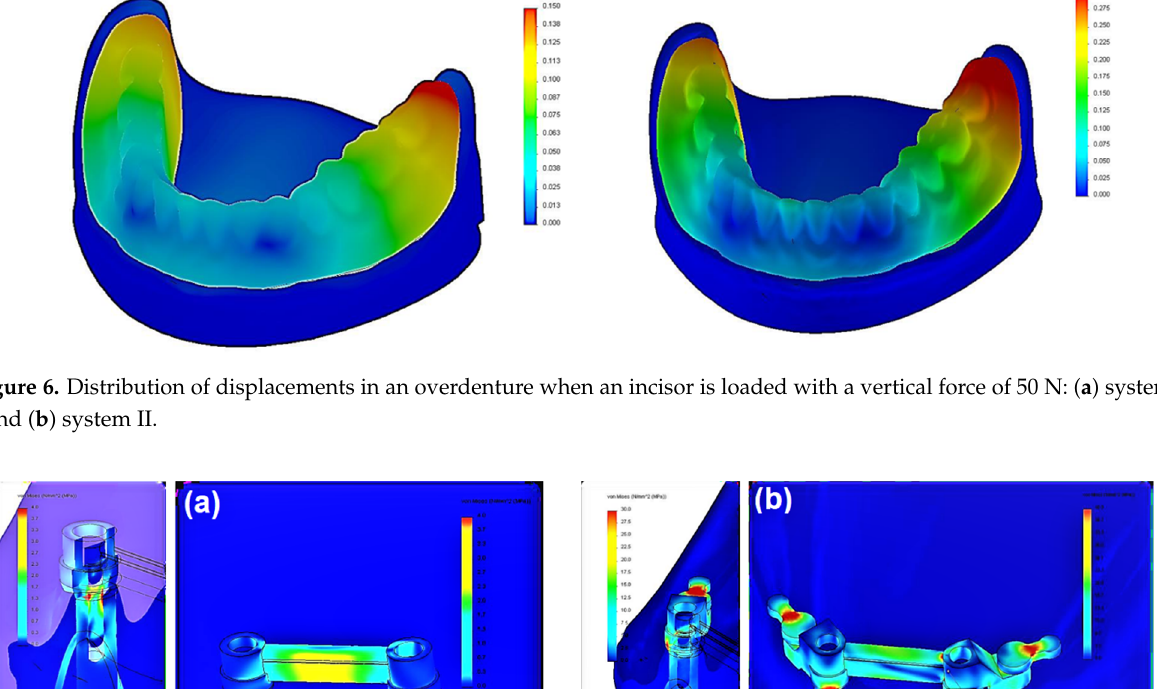
Figure 7. Distribution of stress within an implant and precision element when an incisor is loaded with a vertical force of 50 N: ( a ) system I and ( b ) system II.